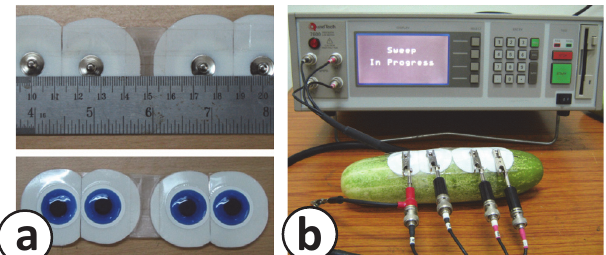
Fig.8: EIS studies on fruits and vegetables using the QuadTech7600 impedance analyzer and ECG electrodes. (a) The ECG electrode-based four-electrode array (EE-FEA) used for EIS studies on fruits and vegetables. (b) EIS studies on fruits and vegetables using the QuadTech7600 impedance